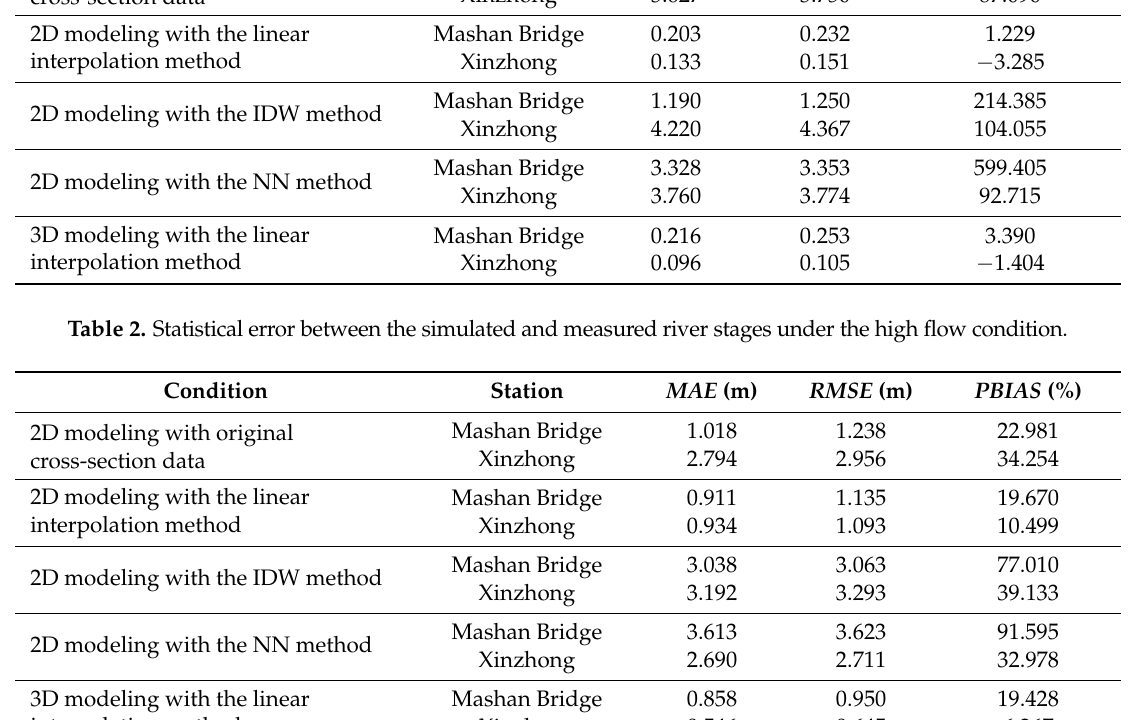
Table 1. Statistical error between the simulated and measured river stages under the low flow condition. Condition